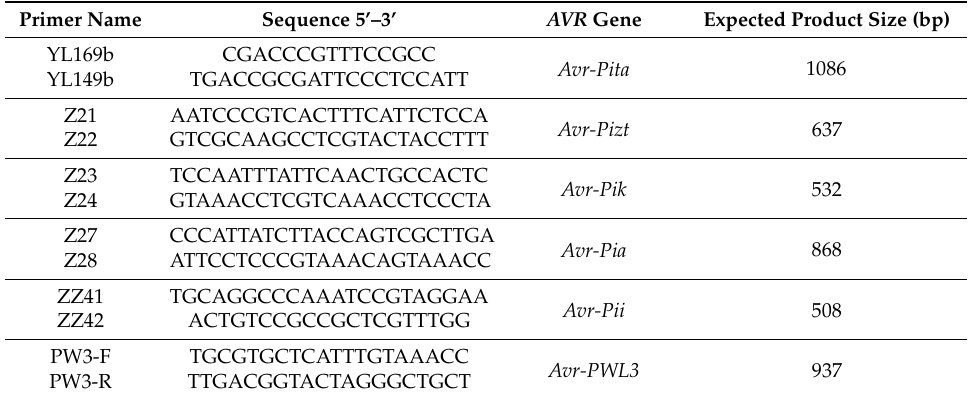
Table 1. Specific sequences, avirulence gene amplified and PCR product size of primers tested against M. oryzae